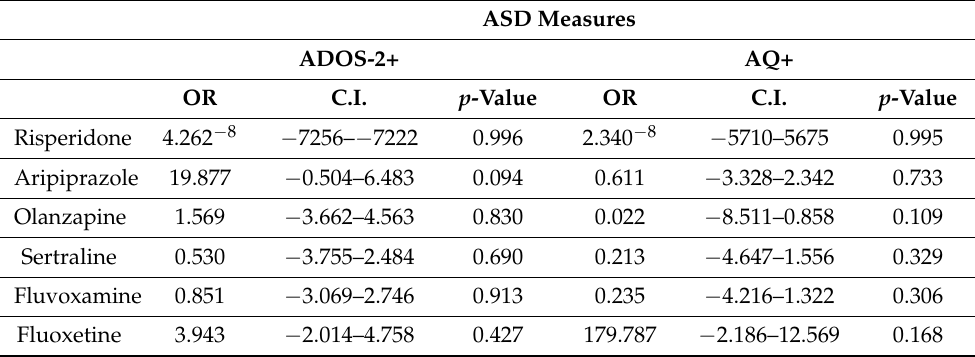
Table 3. Comparisons of psychopharmacological treatments between ASD+ and ASD- patients. ASD